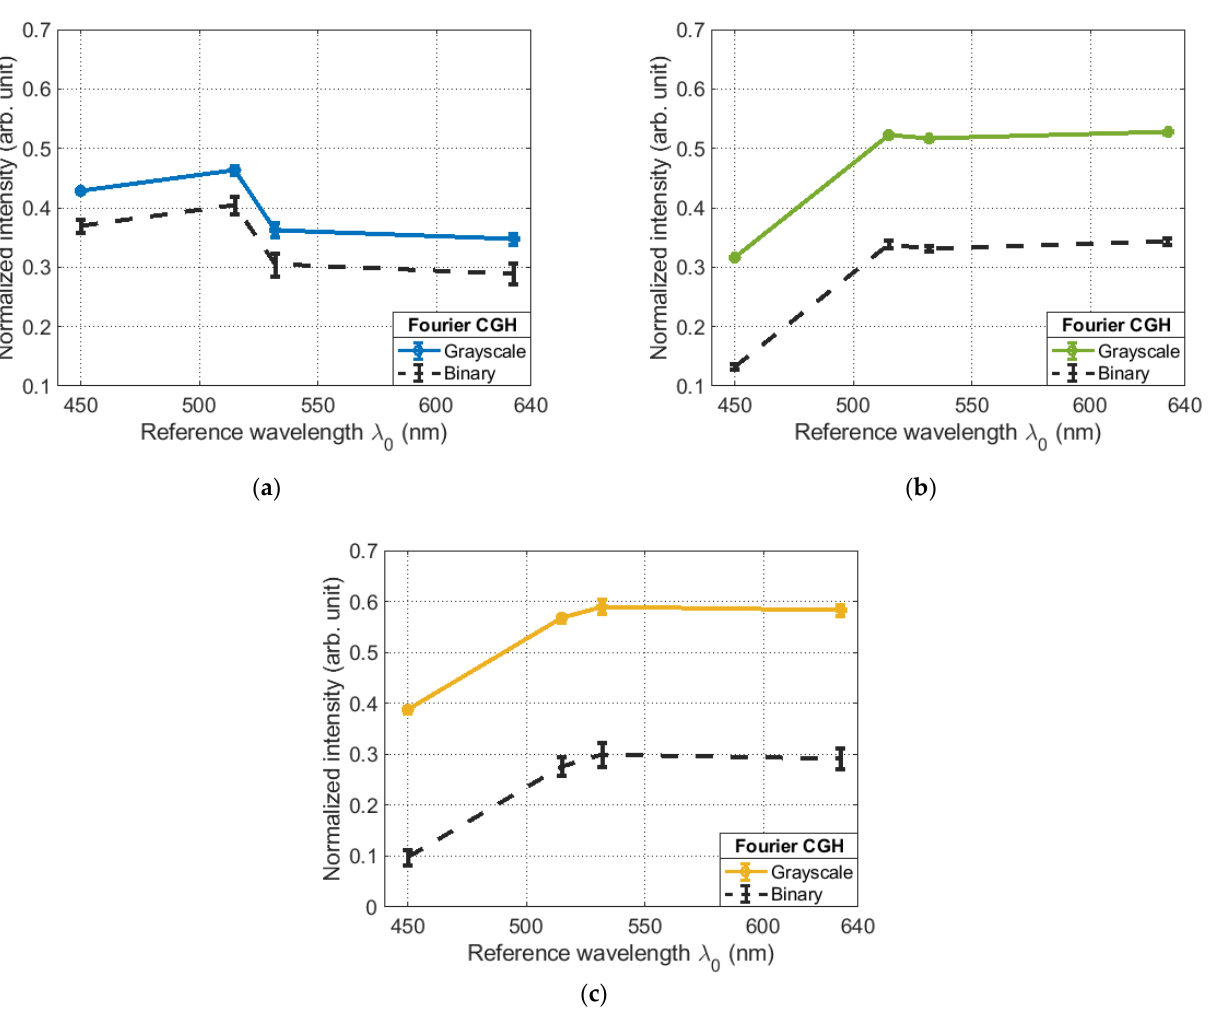
Figure 8. Comparison of the dependence of the maximum of the correlation function on the settings of the SLM relative to the reference wavelength λ_0 for the grayscale Fourier CGHs and binary at the wavelength: ( a ) 𝜆 1 = 473 nm; ( b ) 𝜆 2 = 532 nm; ( с ) 𝜆 3 = 561 nm.